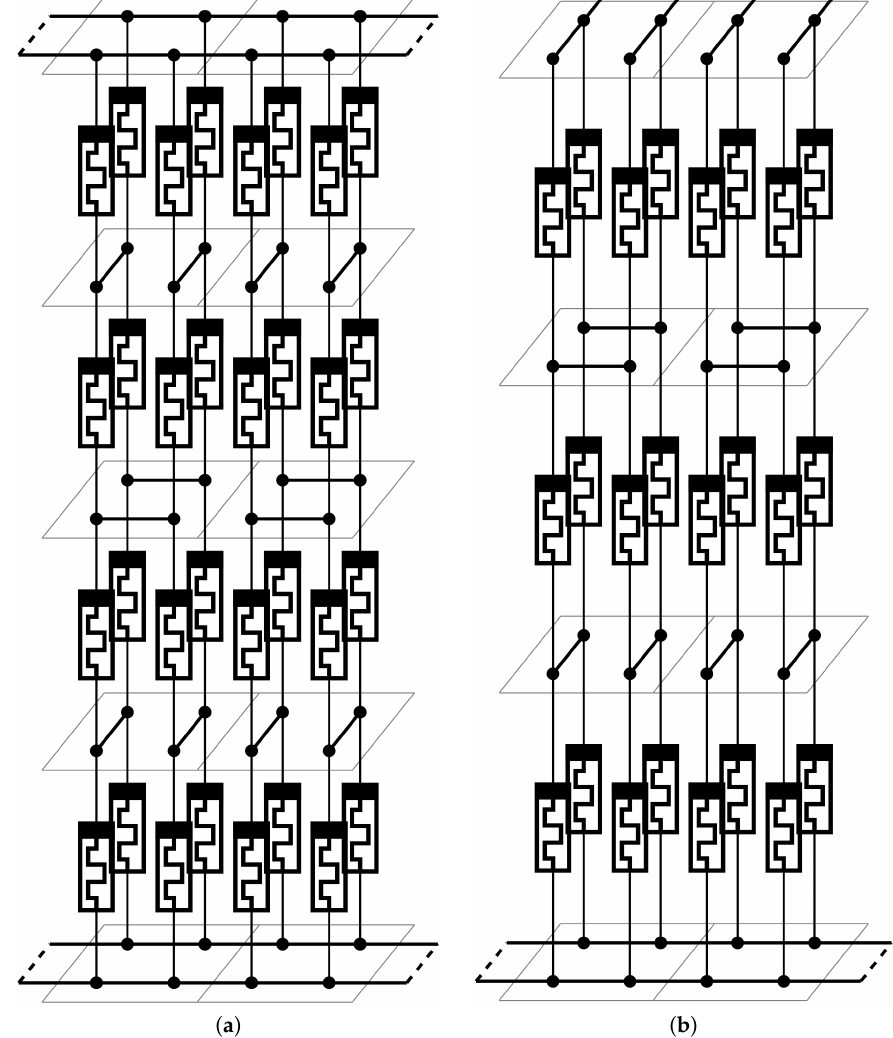
Figure 3. The proposed three dimensional cell structures. ( a ) Two emulated cells from a 2 × 2 × 4 array. ( b ) Two emulated cells from a 2 × 2 × 3